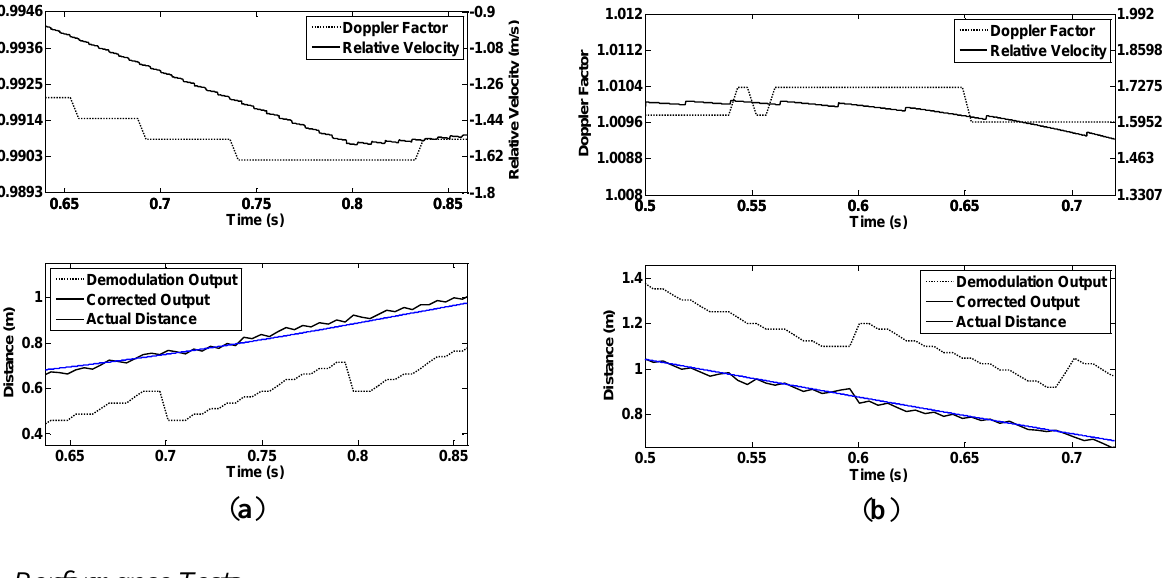
Figure 11. Experiment results of condition 2, the speeds of both the sonar head and the target change ( a ) linearly; and ( b )